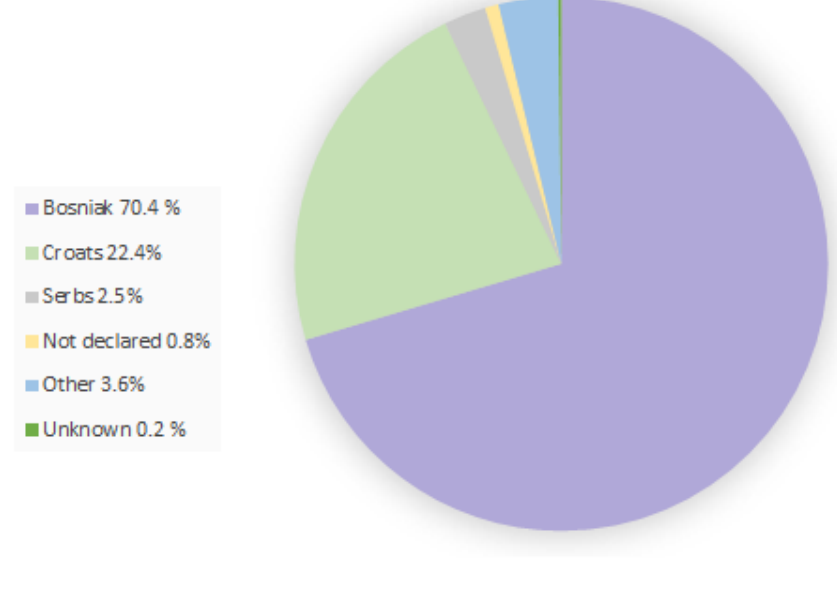
Figure 1. Ethnicities in the Federation of Bosnia and Herzegovina